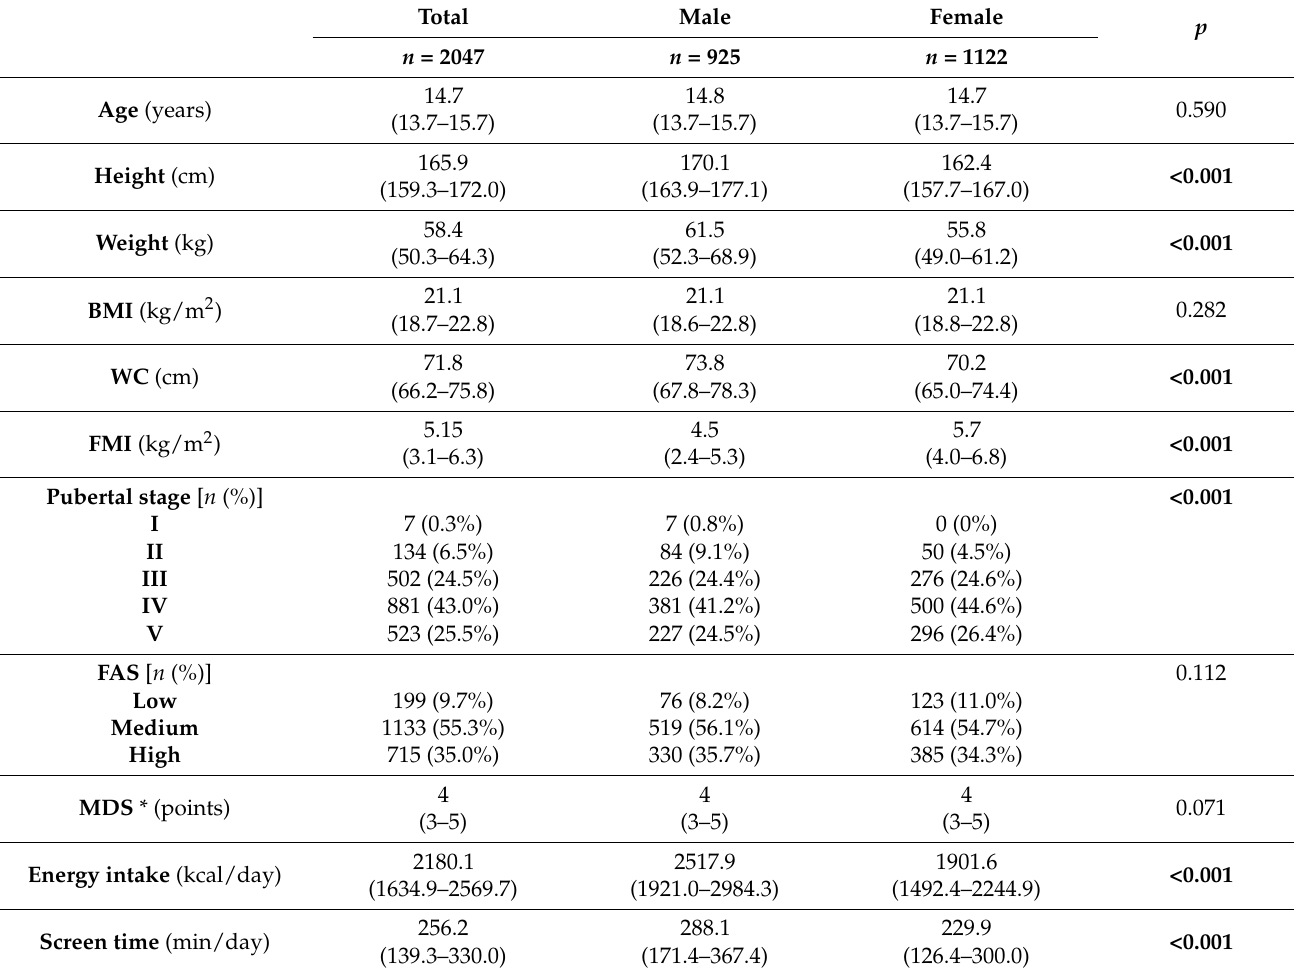
Table 1. Demographics and behavioural characteristics of the Healthy Lifestyle in Europe by Nutrition in Adolescence (HELENA) participants displayed by sex. Total